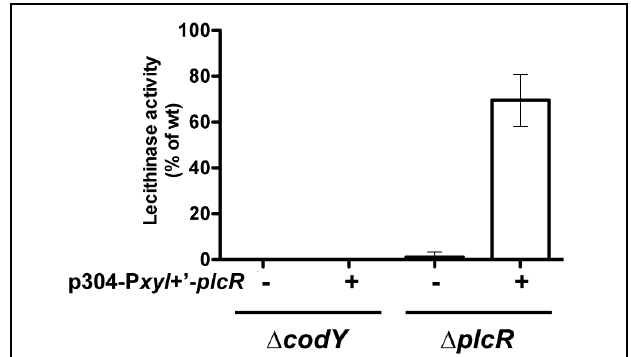
FIGURE 2 | Lecithinase production in Bt (cid:2) codY compared to the wild-type strain when plcR is overexpressed. (cid:2) codY and (cid:2) plcR cells harbor ( + ) or not ( − ) the p304-P xyl + ’- plcR vector carrying a transcriptional fusion between the xylose-inducible promoter P xylA and the plcR gene. Filter-sterilized supernatants from samples harvested 1 h after entry into stationary phase were assayed for lecithinase production. The results are the mean values of two independent experiments, and the error bars represent standard